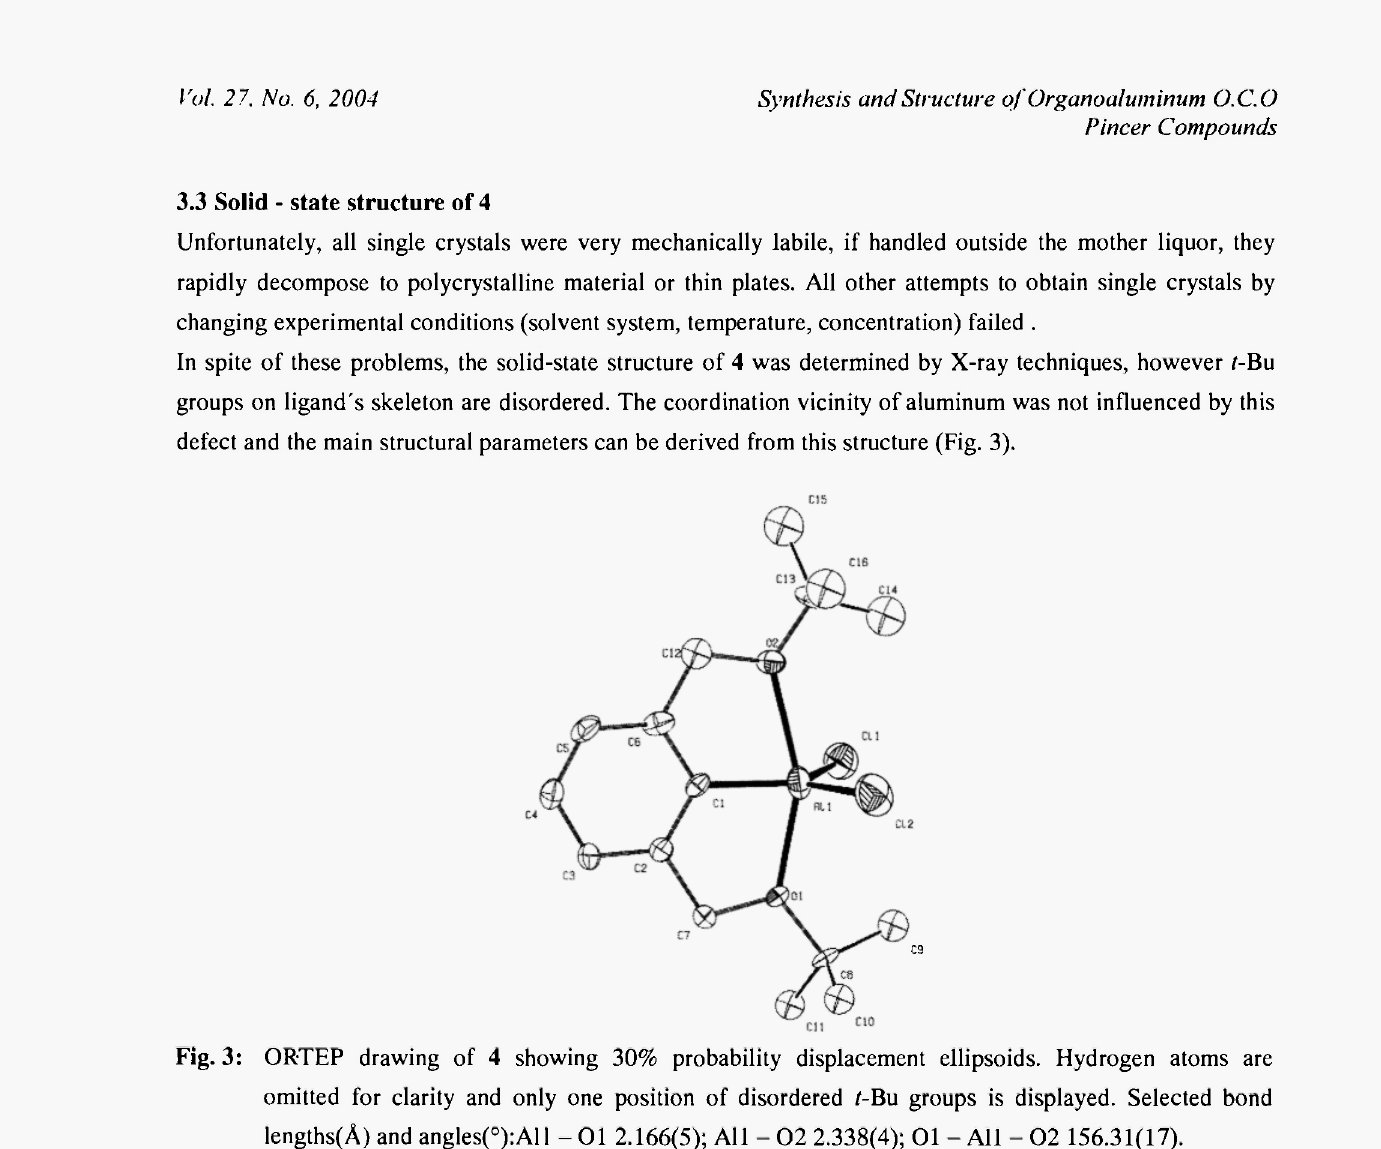
Fig. 3: ORTEP drawing of 4 showing 30% probability displacement ellipsoids. Hydrogen atoms are omitted for clarity and only one position of disordered /-Bu groups is displayed. Selected bond lengths (A) and angles(°):All - 01 2.166(5); All - 02 2.338(4); 01 - All - 02